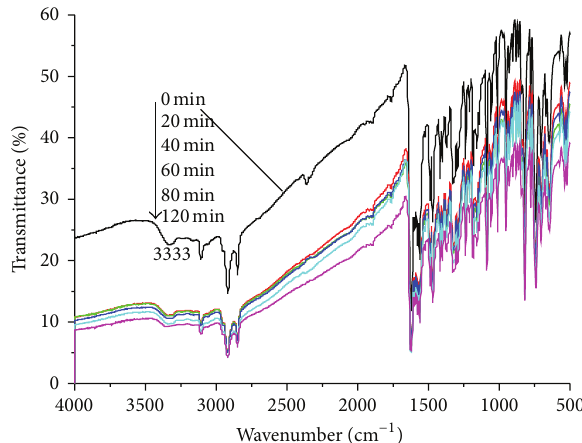
Figure 7: The IR spectra of compound 2 after a period of exposure to UV light.